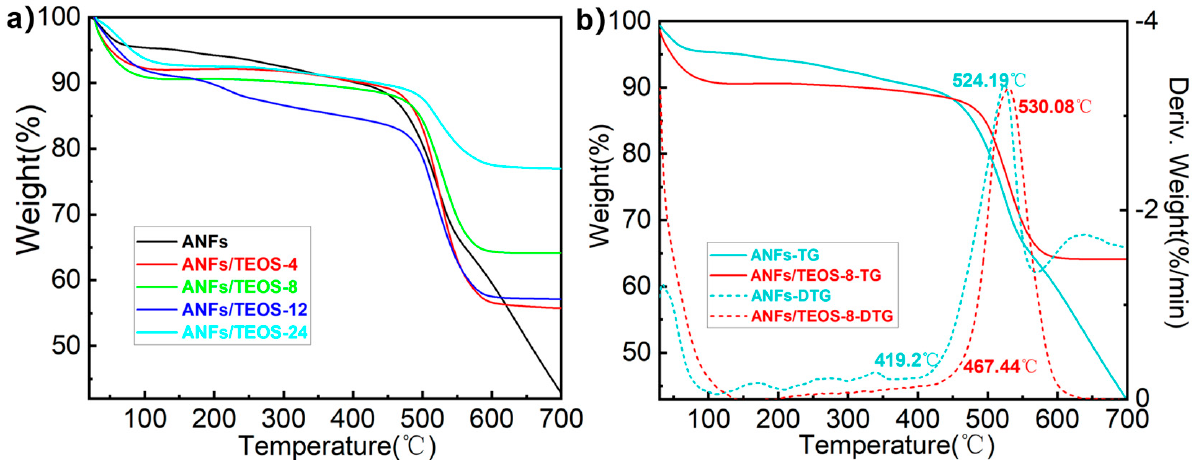
Figure 4. ( a ) The TG curves of ANFs aerogel and aramid fibers@silica aerogels prepared by different CVD times from 25 °C to 700 °C at oxygen atmosphere. ( b ) The comparison of TG and DTG curves between ANFs aerogel and aramid fibers@silica aerogel prepared by CVD 8 h.